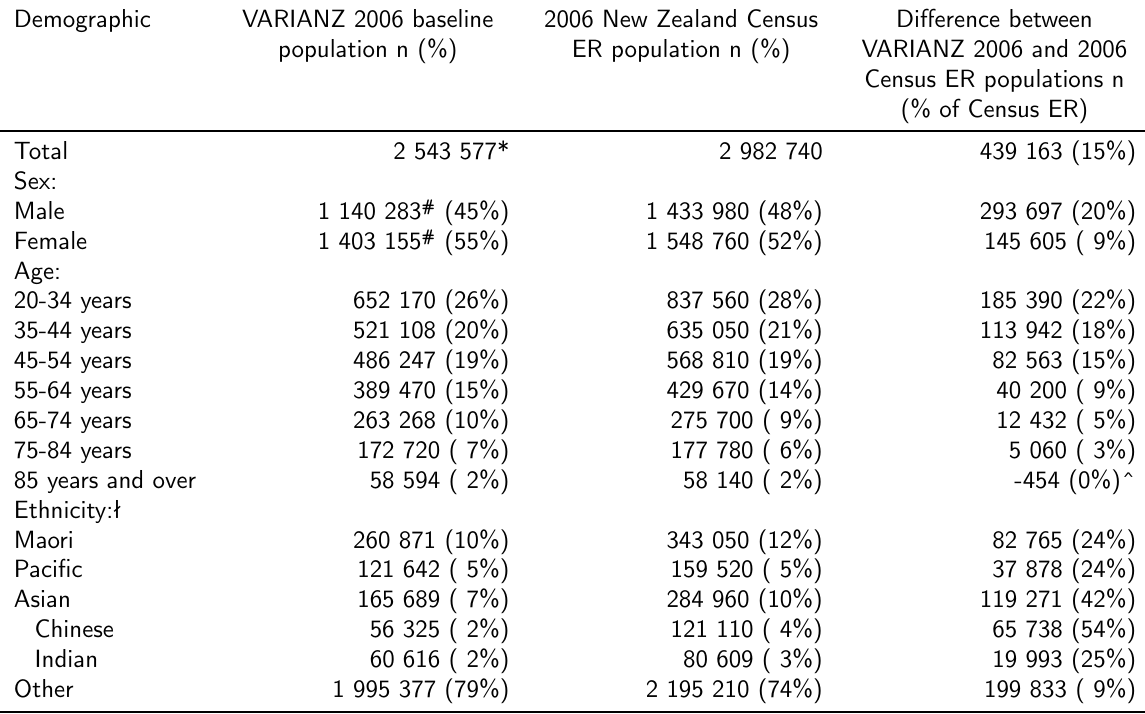
Table 3: Demographic characteristics of the Vascular Risk in Adult New Zealanders 2006 (VARIANZ 2006) baseline population compared to the 2006 New Zealand Census Estimated Resident (ER)